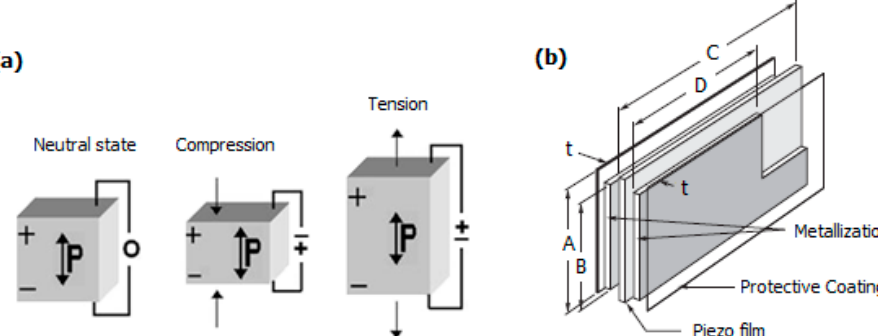
Figure 1. Piezoelectricity: ( a ) piezoelectric effect generated by an external force [33] ( b ) dimensions of a piezo film (with reference to Table 1) [26].